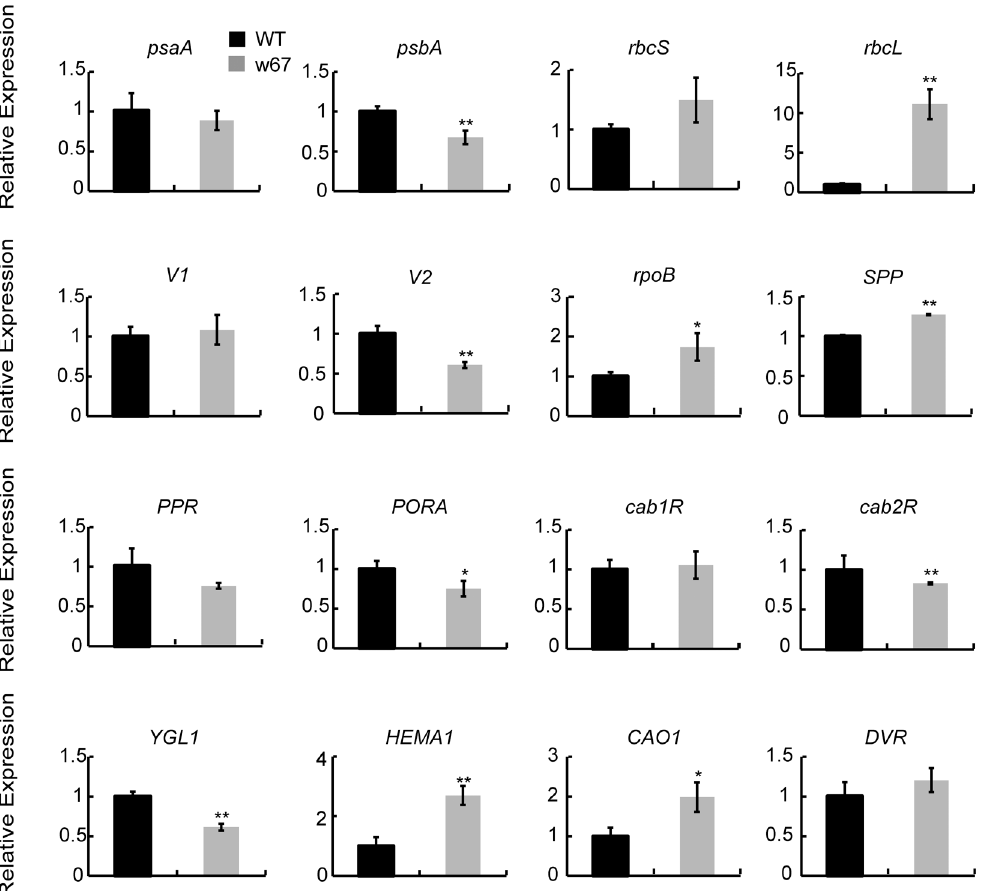
Fig 8. Real-time quantitative reverse transcription PCR analysis. The accession numbers and primer sequences of 16 genes associated with Chl biosynthesis and photosynthesis in IR64 and w67 are listed in S3 Table. The expression levels were determined by real-time PCR and normalized to the ubiqutin . The values are presented as the mean ± SD from three biological replicates. * , Significance at P (cid:2) 0.05; ** , Highly significance at P (cid:2) 0.01.